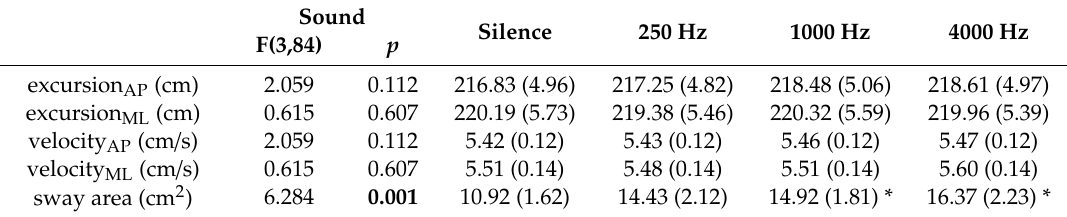
Table 2. The results of repeated measure ANOVA for excursion AP , excursion ML , velocity AP , velocity ML , and sway area. The mean and standard errors cross both groups for each